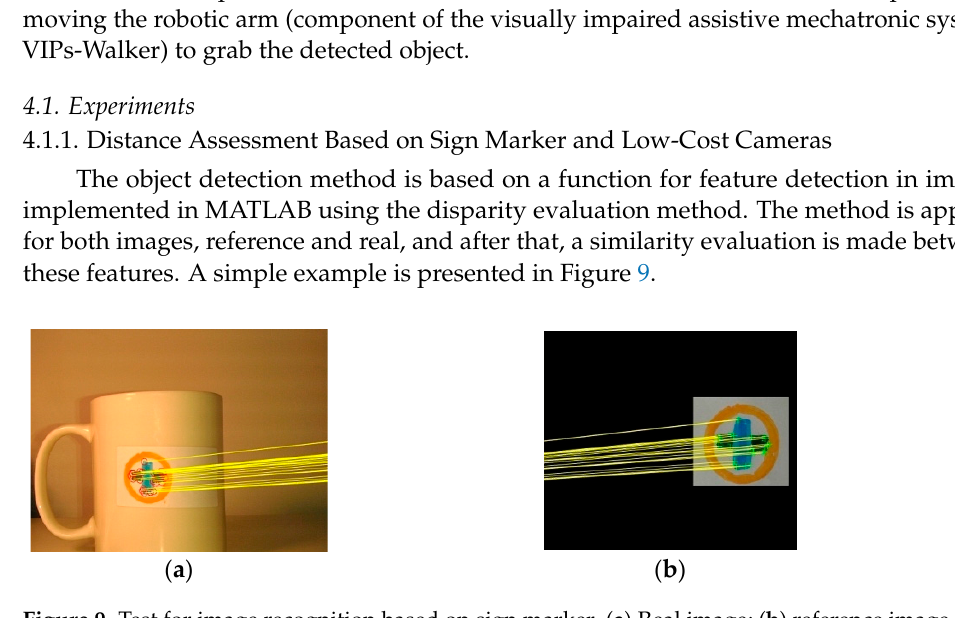
Figure 9. Test for image recognition based on sign marker. ( a ) Real image; ( b ) reference image.